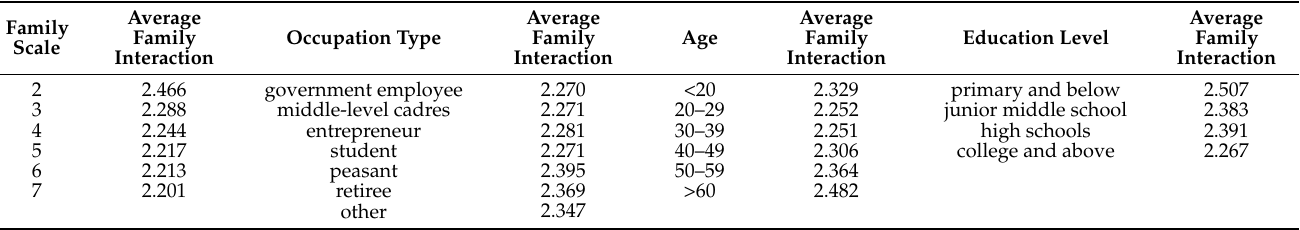
Table 2. The average family interaction of different